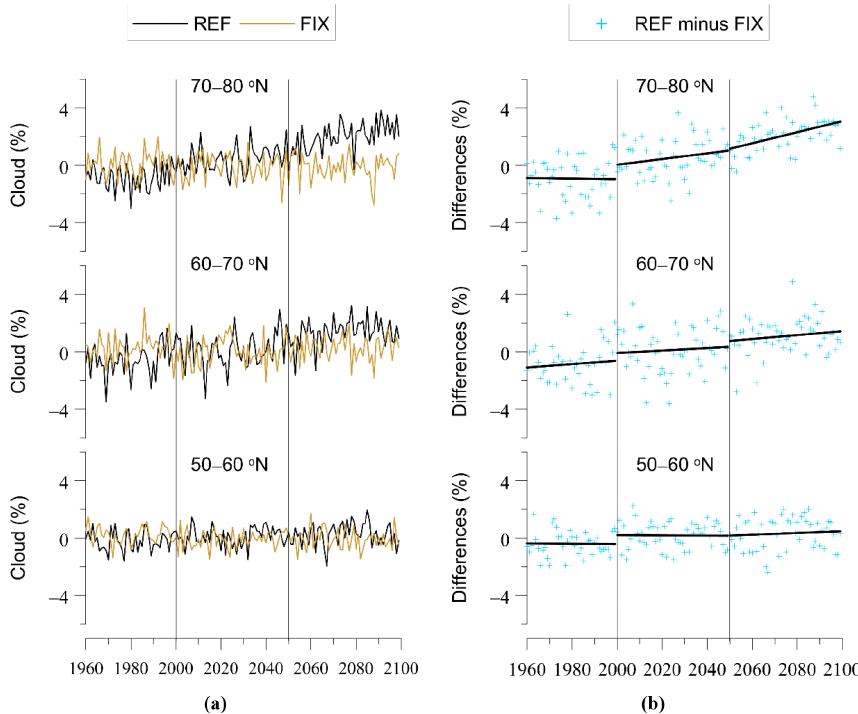
Figure B1. EMAC CCM projections of zonal mean cloud cover for 10 ◦ latitude zones (50–60 ◦ N, 60–70 ◦ N, 70–80 ◦ N), based on simulations with increasing and fixed-GHG mixing ratios. (a) REF is the simulation with increasing GHGs according to RCP 6.0. FIX is the simulation with fixed-GHG emissions at 1960 levels. (b) Difference between the two model simulations, as an indicator of the impact of increasing GHGs. The y axis in (a) shows yearly averaged cloud cover data (in %) calculated from de-seasonalized monthly data. The monthly data were de-seasonalized relative to the long-term monthly mean (1990–2019) and were expressed in percent. For the northern high latitudes, the annual average refers to the average of monthly anomalies from March to September.